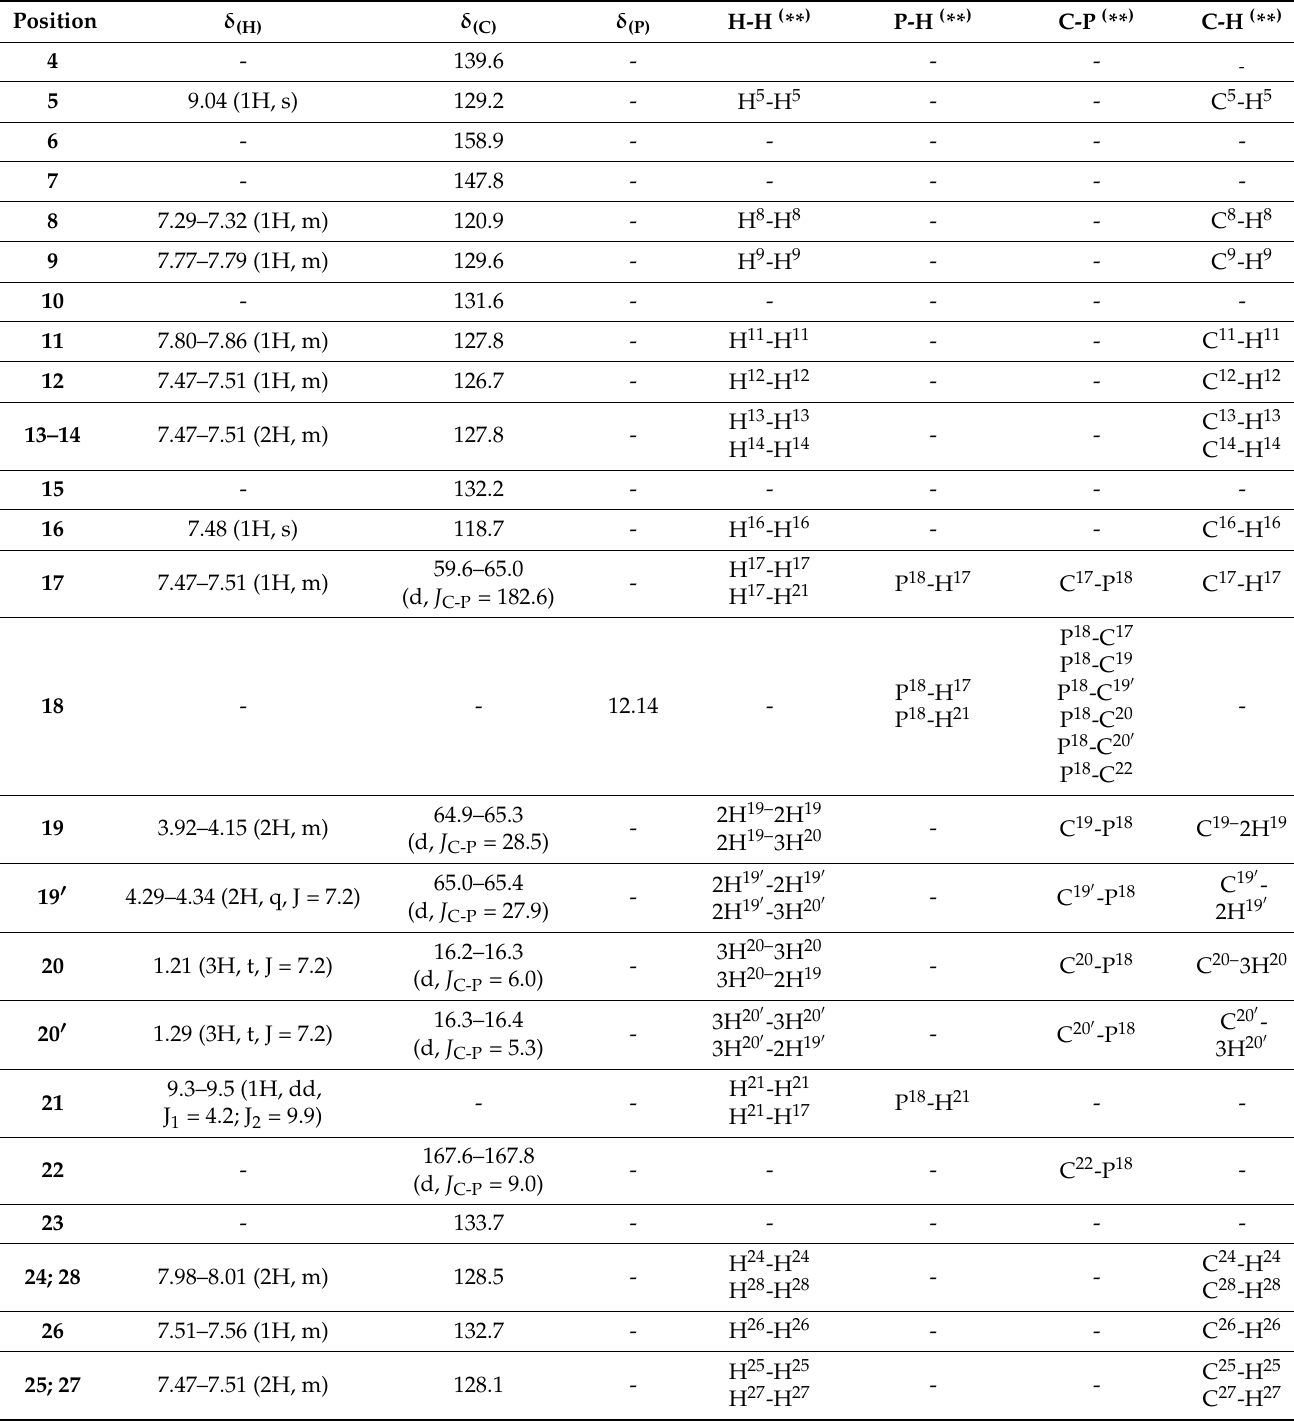
Table 1. 1 H- (300.13 MHz), 13 C- (75.47 MHz), and 31 P (121.49 MHz) NMR spectral data for the title compound in CDCl 3 , including results obtained by homonuclear 2D shift-correlated COSY and heteronuclear 2D shift-correlated HSQC. Chemical shifts ( δ , ppm) and coupling constants ( J , Hz, in parenthesis) ( * )